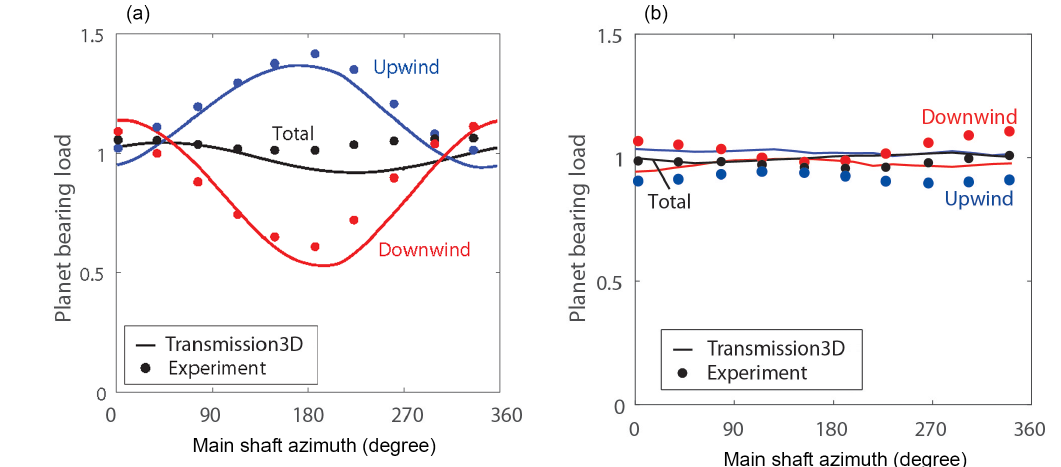
Figure 7. Planet CRB (a) and TRB (b) loads in pure